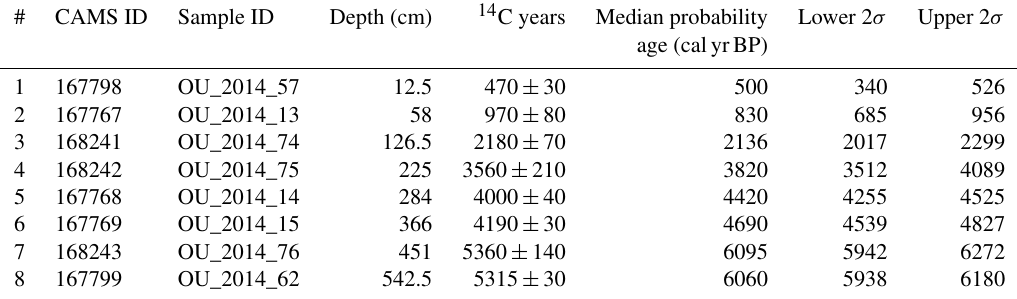
Table 1. Median probability ages and associated error for eight AMS radiocarbon-dated terrestrial organic macrofossil fragments from 36P4, Hanfield Inlet. Radiocarbon years were converted to calyrBP using SHCal13 (Hogg et al., 2013) in Calib 7.0.4 (Stuvier and Reimer, 1993).